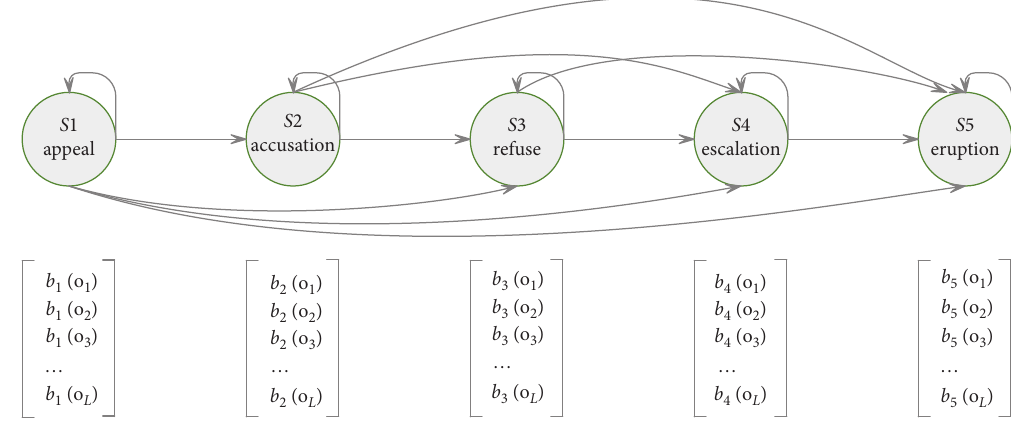
Figure 6: The structure of HSMM with five